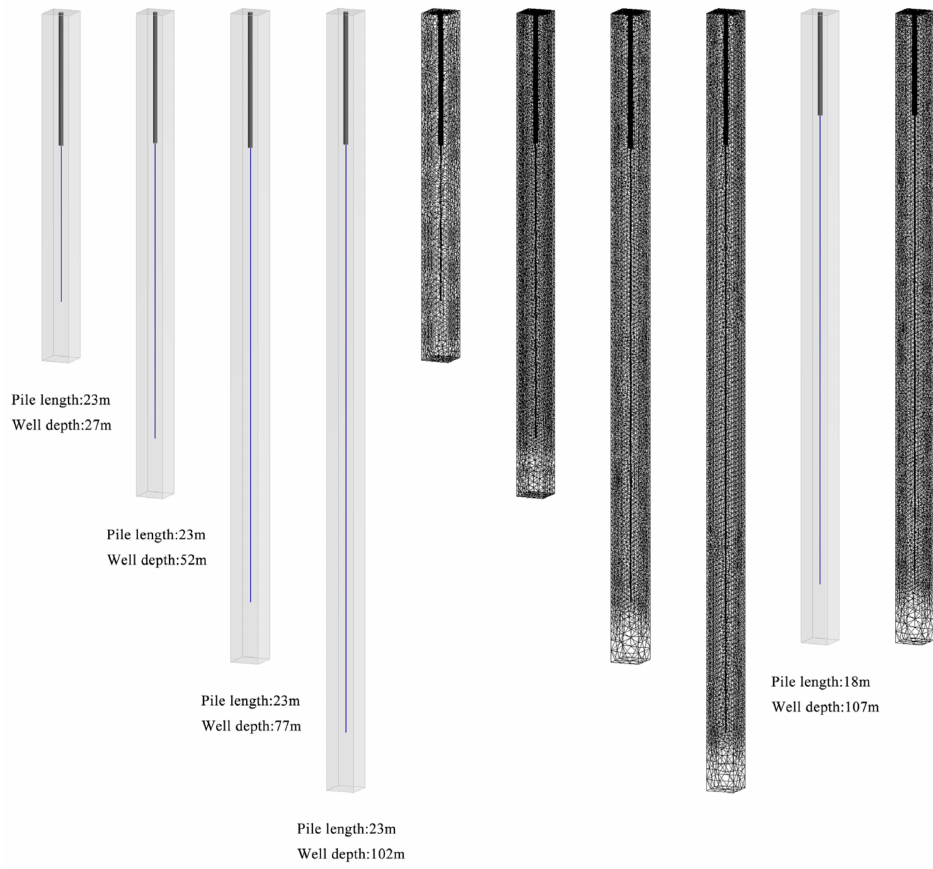
Figure 3. Model and grid division diagram of deep buried pipe energy pile.